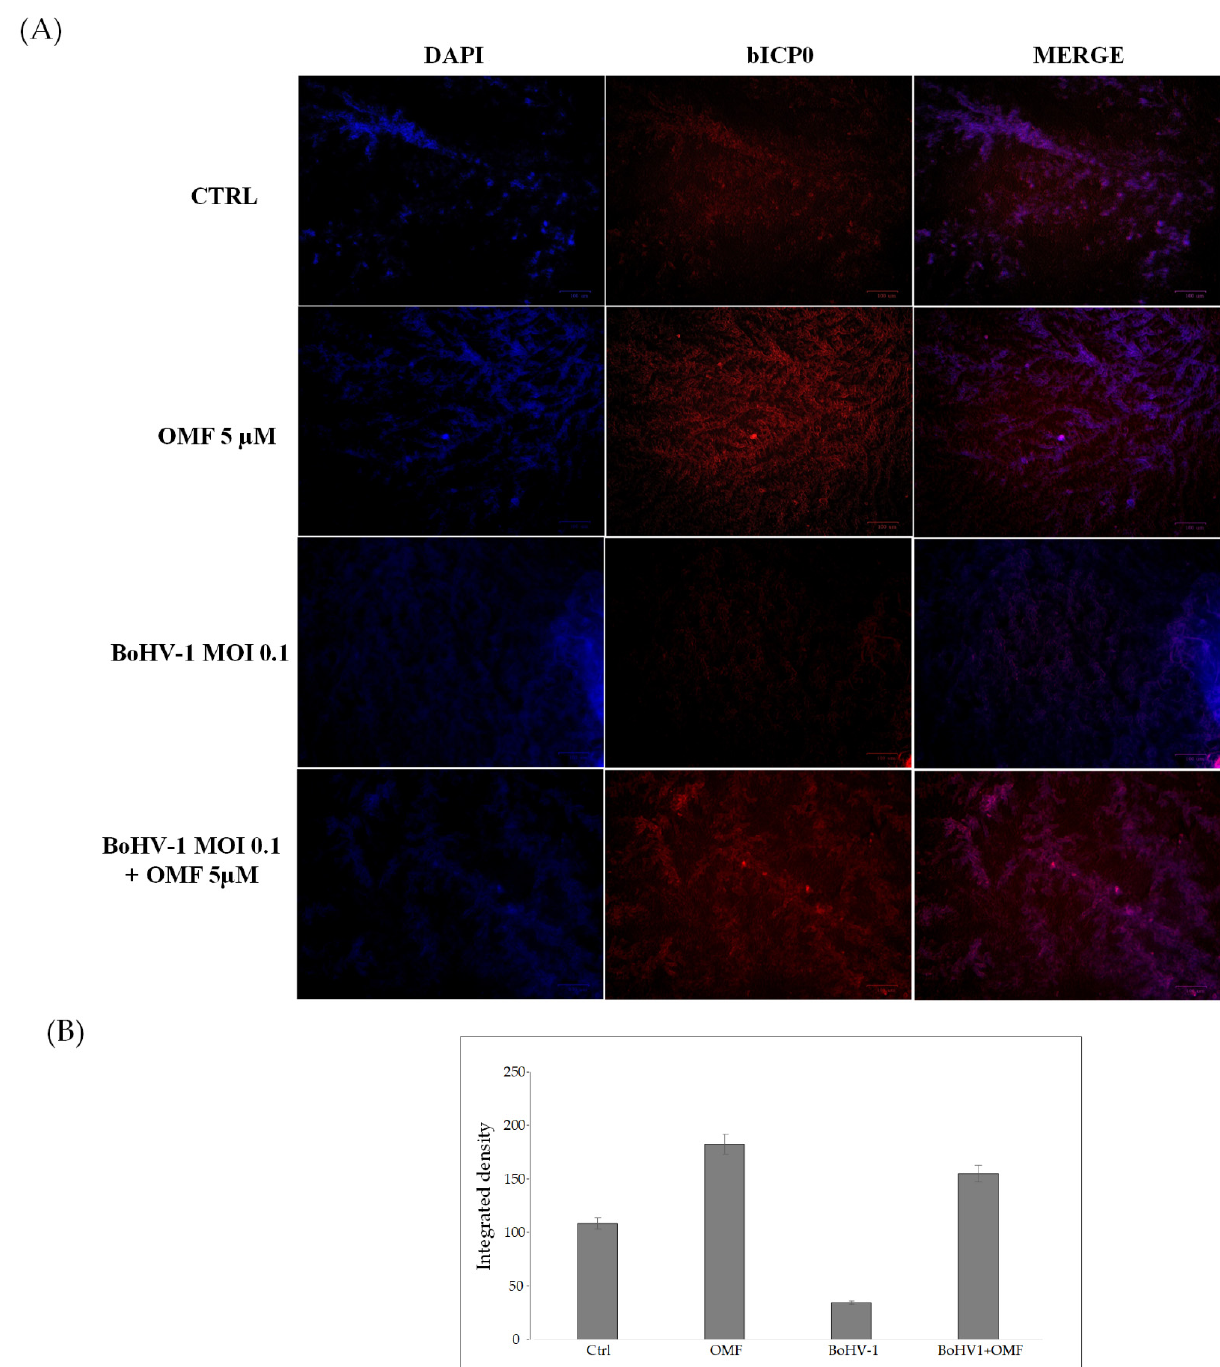
Figure 7. OMF induces the expression of AhR during BoHV-1 infection in MDBK cells. ( A ) Representative microphotographs of uninfected (control) or infected cells (BoHV-1), OMF-treated infected (BoHV-1+OMF), and uninfected cells (OMF), after 24 h of infection, stained with immunofluorescence for AhR (red fluorescence), as described in the Methods section. Nuclei were counterstained with DAPI. AhR was expressed in MDBK cells and localized in both the nucleus and cytoplasm. The expression of AhR was induced in the presence of OMF. During infection, the expression of AhR was drastically reduced. In the presence of OMF, the expression of AhR was remarkably enhanced during BoHV-1 infection. Scale bar 100 µ ( B ) Bars represent the mean ratio generated from the total integrated density (product of the area and mean intensity of fluorescence) of the AhR expression evaluated by ImageJ. Error bars represent standard error